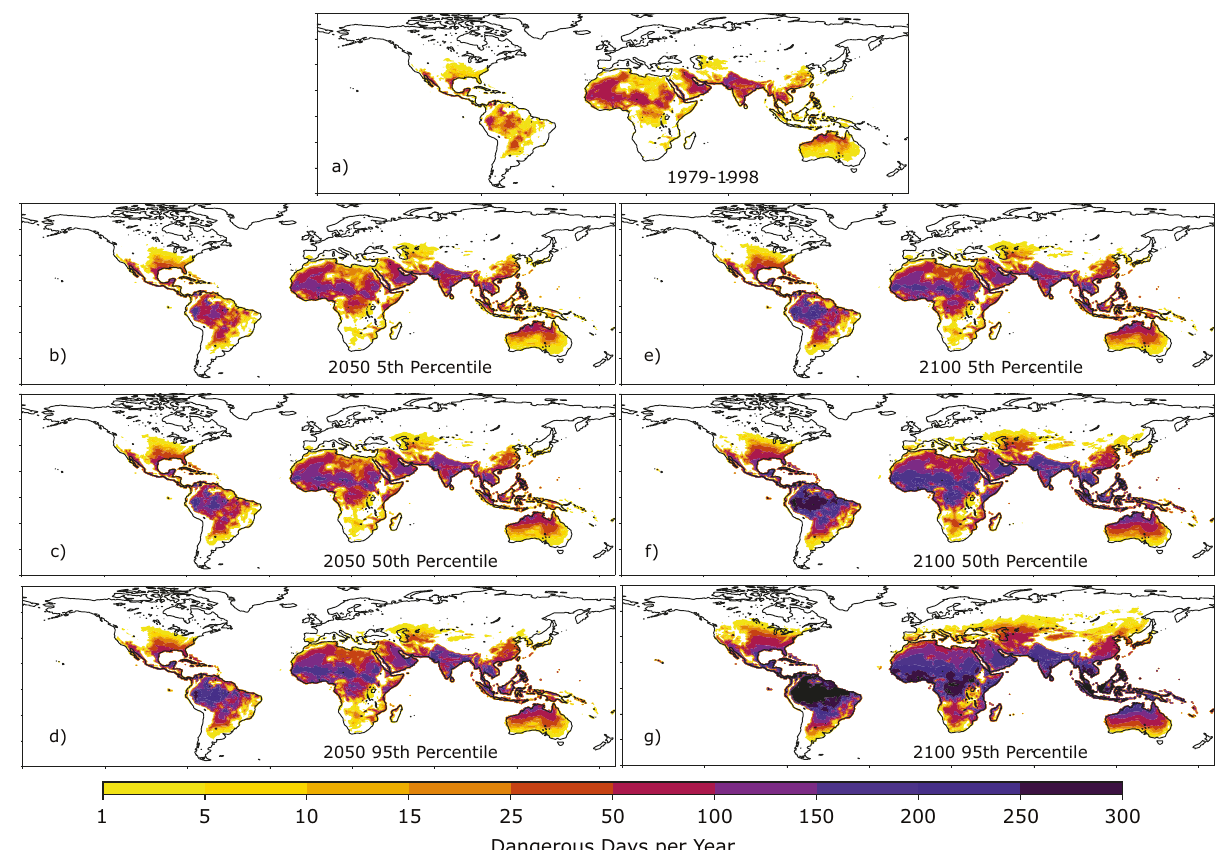
Fig. 3 Projections of dangerous Heat Index values. a shows the average number of days per year when the dangerous Heat Index threshold was exceeded in the historical record (1979 – 1998). b – g show the same quantity under the various climate change scenarios noted in each panel.